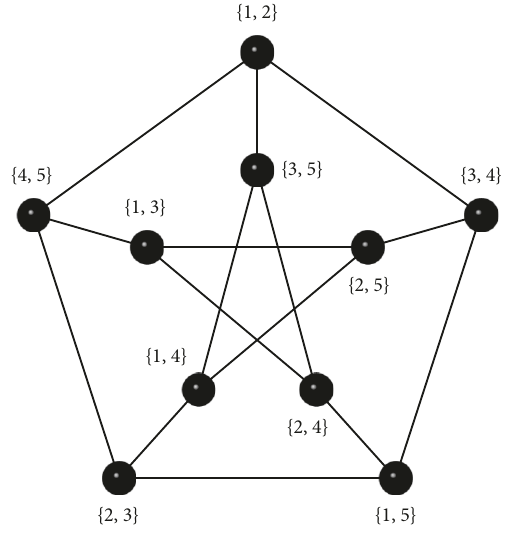
Figure 1: The Petersen graph KG ( 2 , 5 )